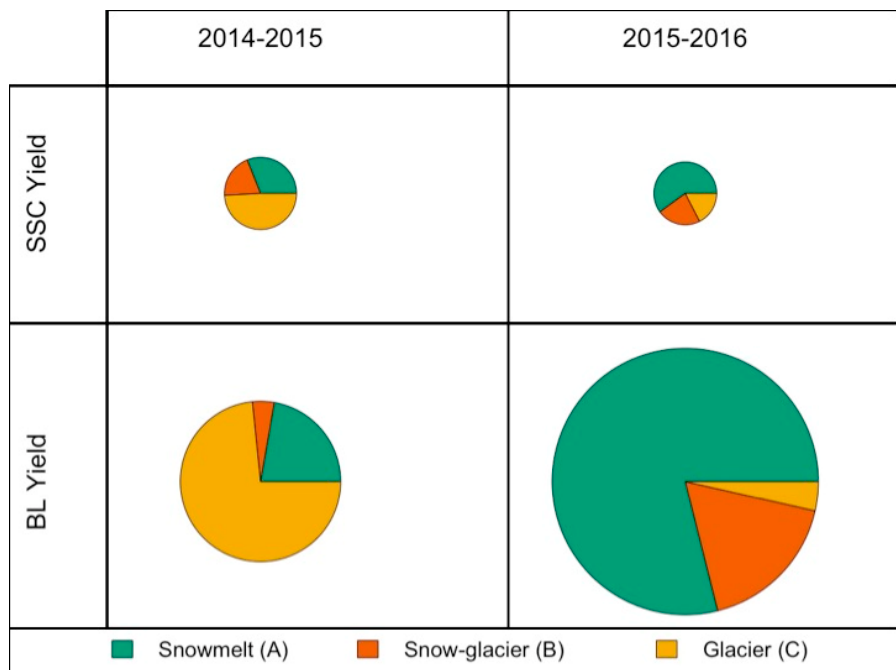
Figure 14. Suspended and bedload transport yield contribution according to the water sources for each ablation season. The size of each pie represents the sediment yield (in ton km –2 ) relative to the maximum sediment yield. The main origin of runoff is split in snowmelt ( A ), snow and glacier melting ( B ) and glacier melting ( C ).